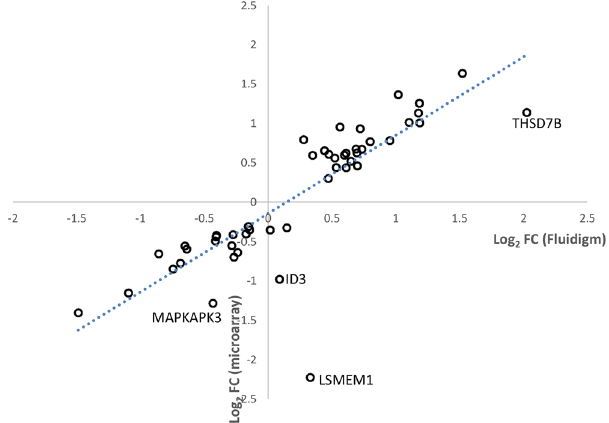
Figure 4. Correlation between the log2 fold-change (pHu − /pHu + ) of gene expression from microarray and quantitative RT-PCR microfluidic technologies.